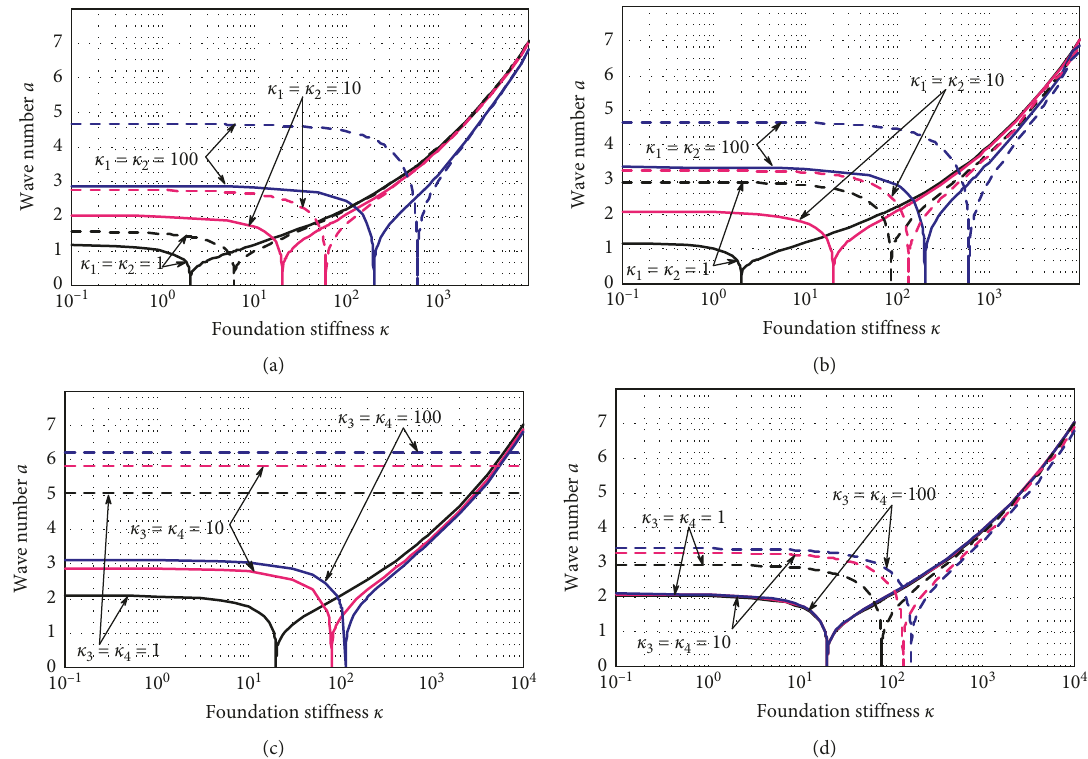
Figure 6: Variations of the first two wave numbers, a cases: (a) κ 3